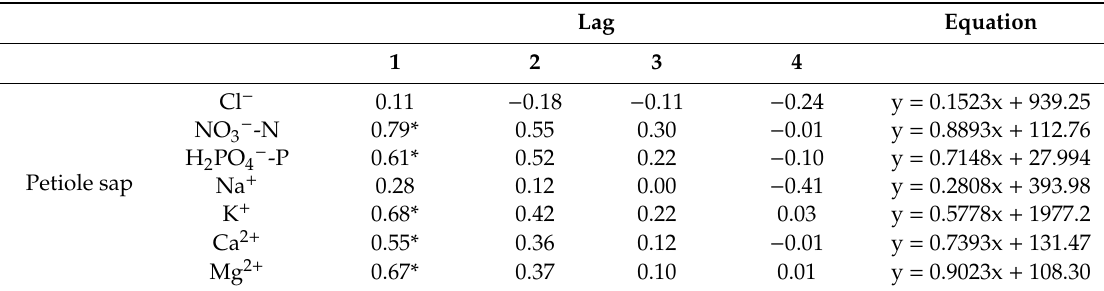
Table 4. Autocorrelation of nutrient concentrations in petiole sap over time (1: determination in